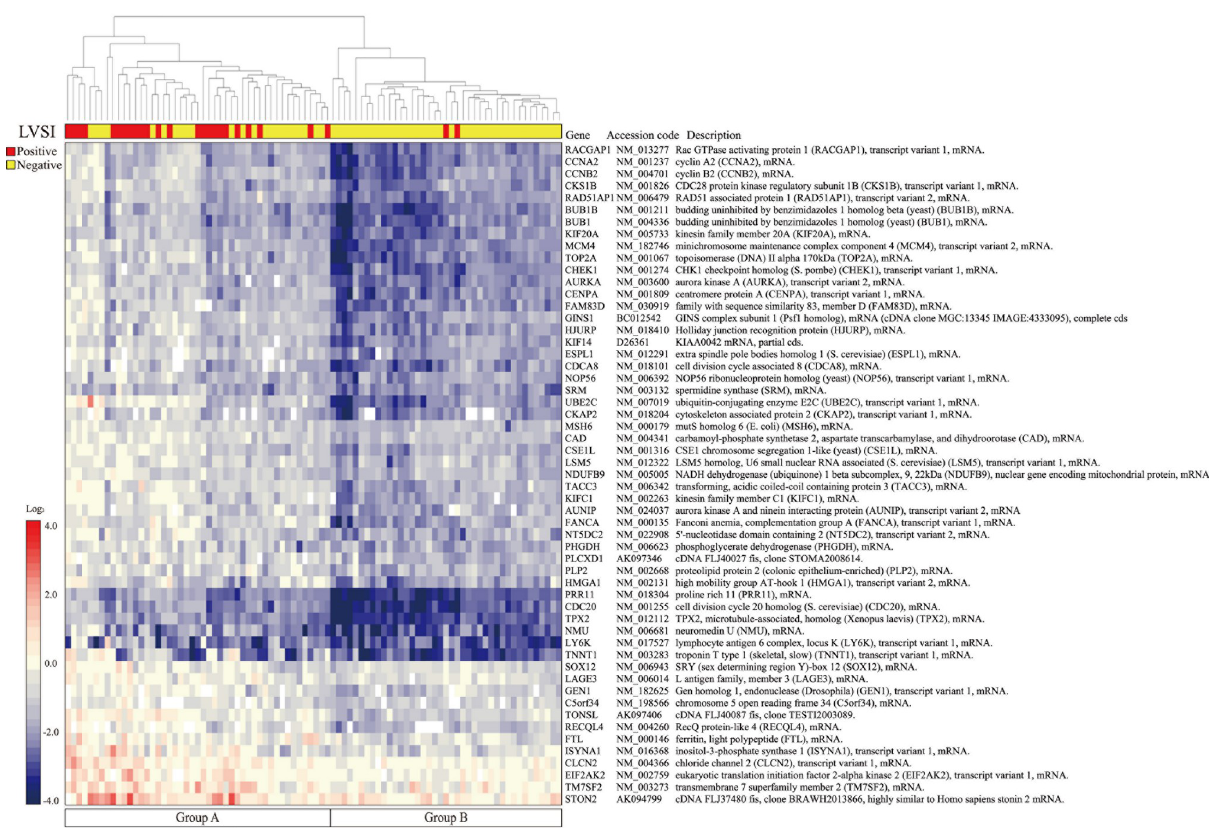
Fig 1. Hierarchical clustering of 55 candidate genes with statistically differentiated expression between patients with and without LVSI. On the heat map, red represents up-regulation and blue represents down-regulation. Two main groups, A and B, were